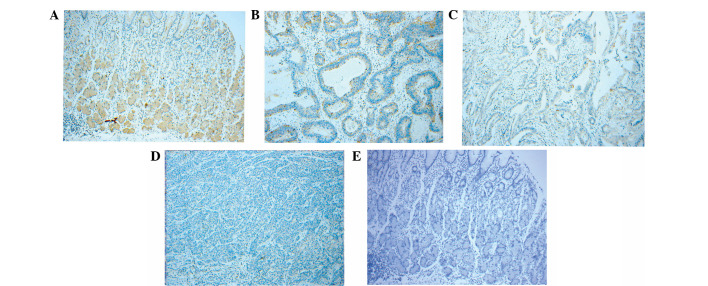
Immunohistochemical staining analysis of the downregulated expression of TFF2 protein in gastric cancer tissues and the correlation with clinicopathological data. Representative photomicrographs of immunohistochemical staining for TFF2 in paraffin-embedded sections of gastric tissues. (A) Normal stomach and (B) well-, (C) moderately and (D) poorly differentiated gastric cancer (intestinal type) tissues and (E) the absence of immunolabeling using anti-TFF2 antibody (P19) blocked with TFF2 antigen. Magnification, ×100. TFF2, trefoil factor 2.